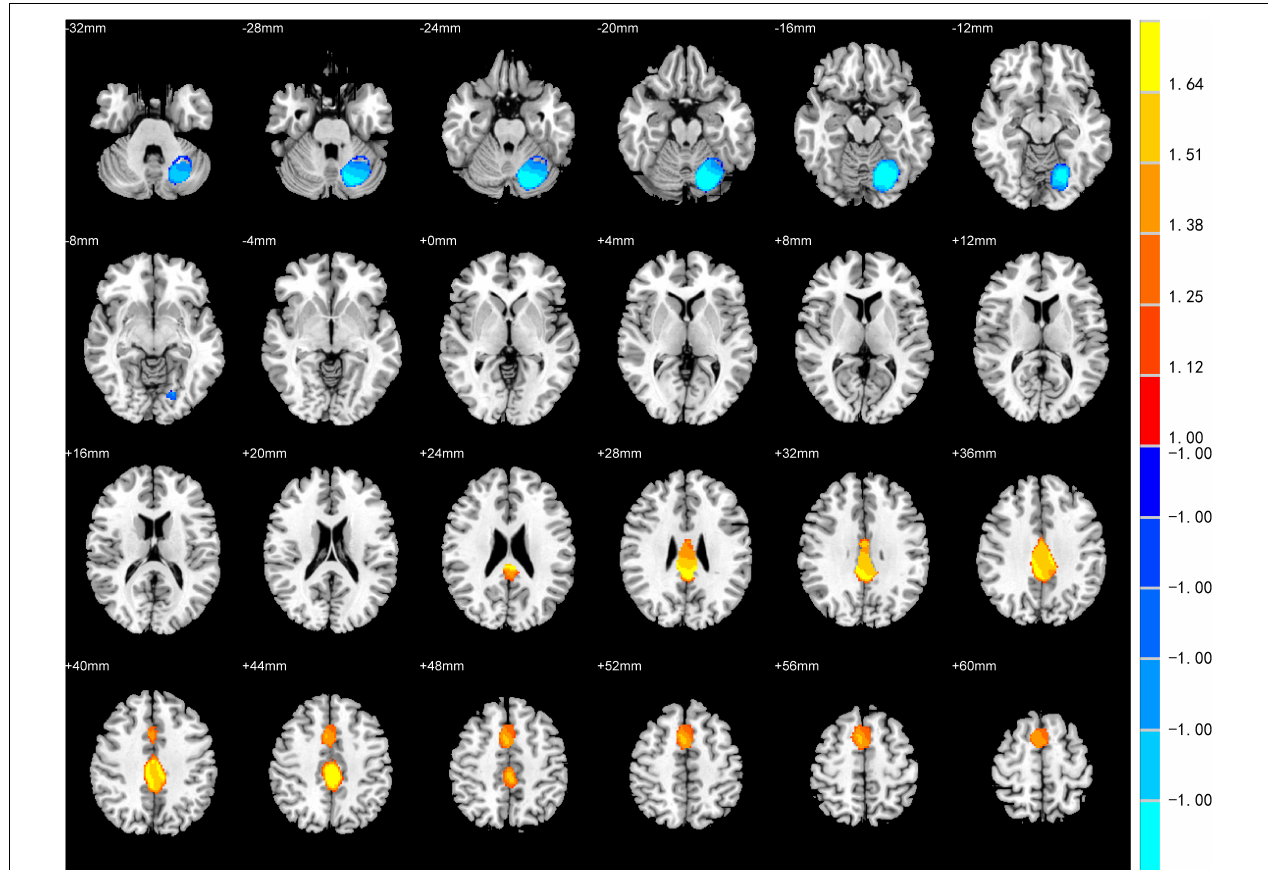
FIGURE 2 | Statistically significant effects of meta-analysis for Parkinson’s disease (PD) patients with depression vs. PD patients without depression. Voxel threshold p < 0.005, peak height threshold: peak SDM-Z > 1.000, extent threshold: cluster size ≥ 10 voxels. Increased activity in PD patients with depression is indicated in yellow and decreased activity in